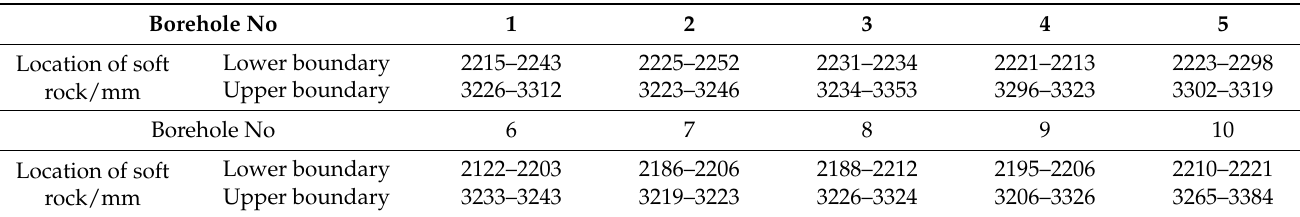
Table 6. Identification Data of the Strata Interface